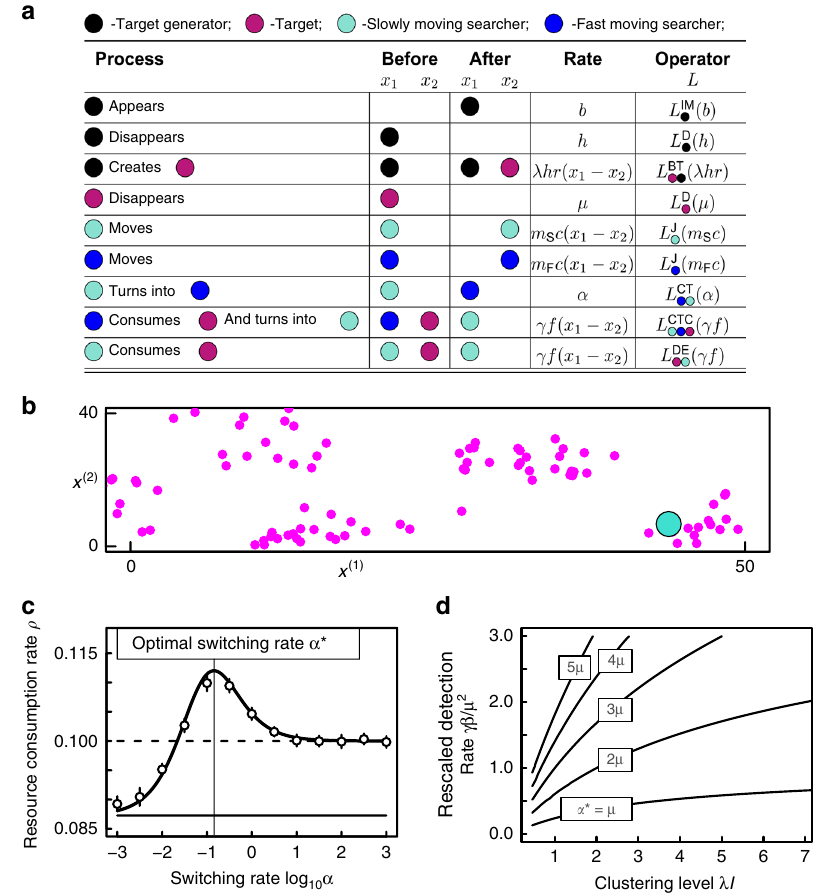
Fig. 5 Optimal foraging model. a shows a graphical de fi nition of the model and b shows a simulation snapshot, illustrating a forager (large cyan circle) that has found a resource aggregate, and has switched to the slow movement mode to consume resources (small magenta circles). c shows how mean resource consumption rate ρ varies from a totally stationary searcher ( α ¼ 0; continuous horizontal line) through a searcher following the optimal rate α ? (vertical line) to a highly mobile searcher ( α ! 1 , dashed line). In c , the dots with error bars show simulation results, whereas the lines follow the ϵ d ρ analytical prediction of ρ (cid:8) ρ (see Eq. (1)). The contour lines in d show the optimal switching rate α ? as a function of the rescaled detection rate 0 þ 1 γβ = μ 2 of the searcher and the clustering level λ I of the targets. Error bars represent three standard errors. Parameters are shown in the Methods